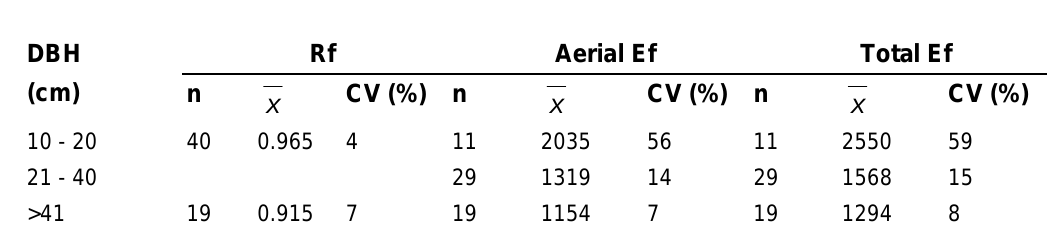
Diameter-Class Values for Biomass